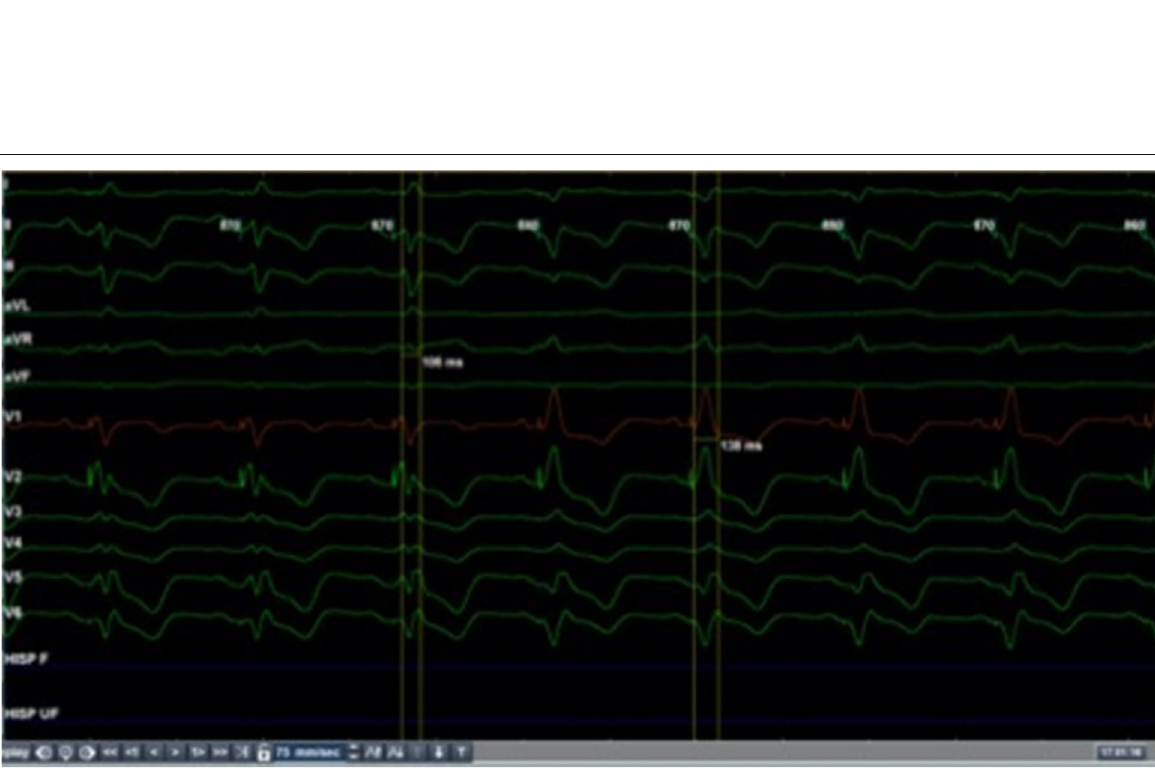
Fig. 5 QRS resulting with HBP + LV pacing (106 ms) and only LV pacing (138